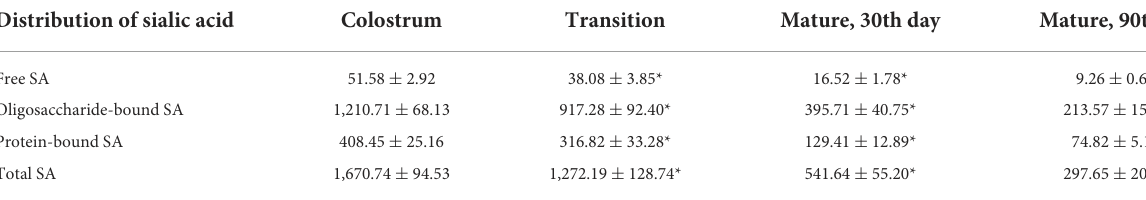
TABLE 1 The concentration of sialic acid in human milk at 4-time points during lactation (mg/L, mean ± SE, n = 33).